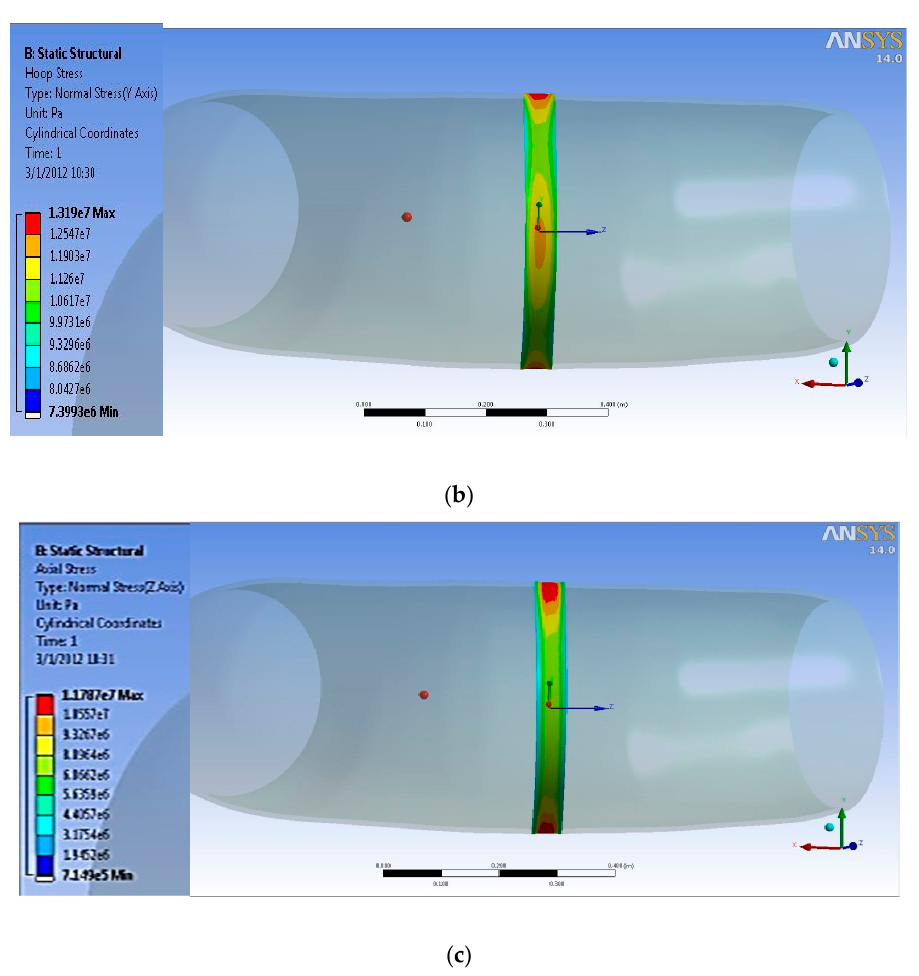
Figure 19. Contours of static safety factor and hoop stress and axial stress at the center of the elbow-joint.